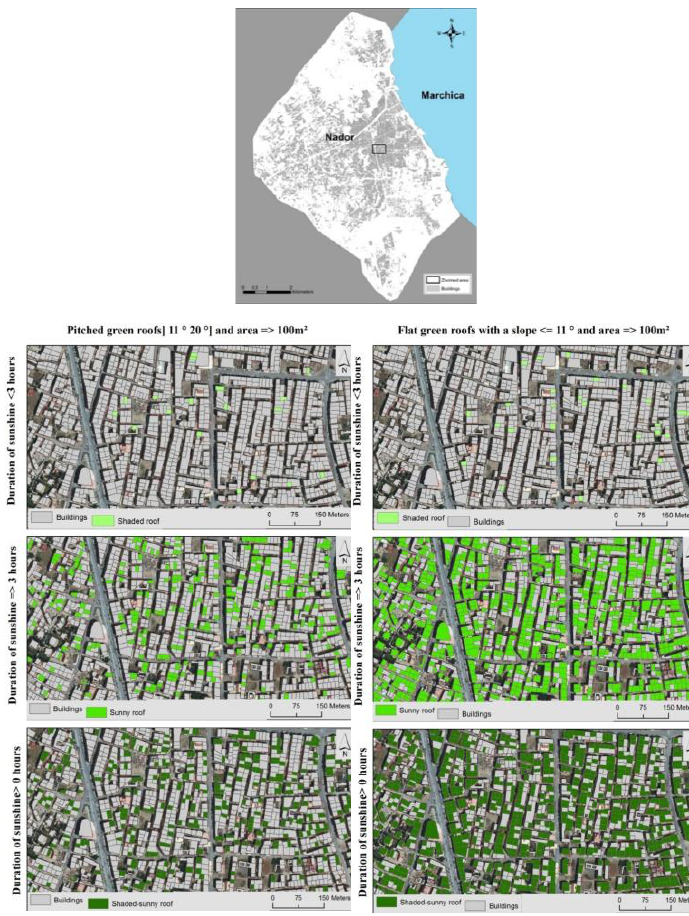
Figure 4. Potential green zone on the roof depending on the inclination of the roof and sunshine